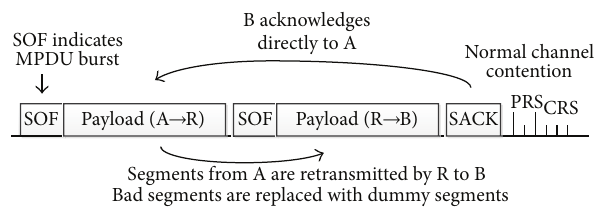
Figure 22: Immediate repeating channel access for